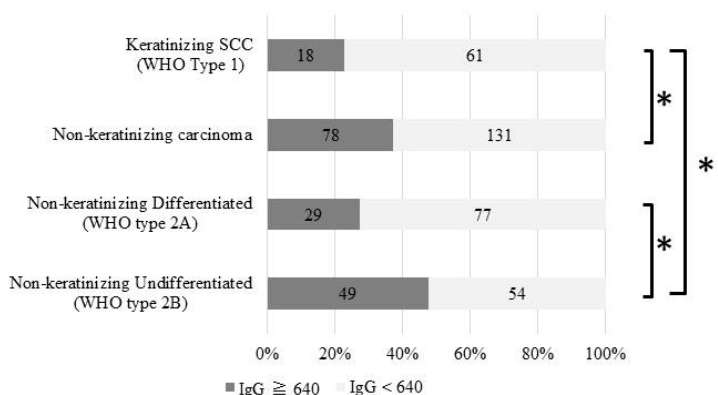
Figure 2. Positive rates of serum antibodies to Epstein–Barr-related antigens. Gray boxes represent anti-EBV-VCA IgG titers of ≥ 640 mg/dL, and white boxes represent titers of <640 mg/dL. Numbers in the boxes indicate the number of cases. * Fisher test: p < 0.05.